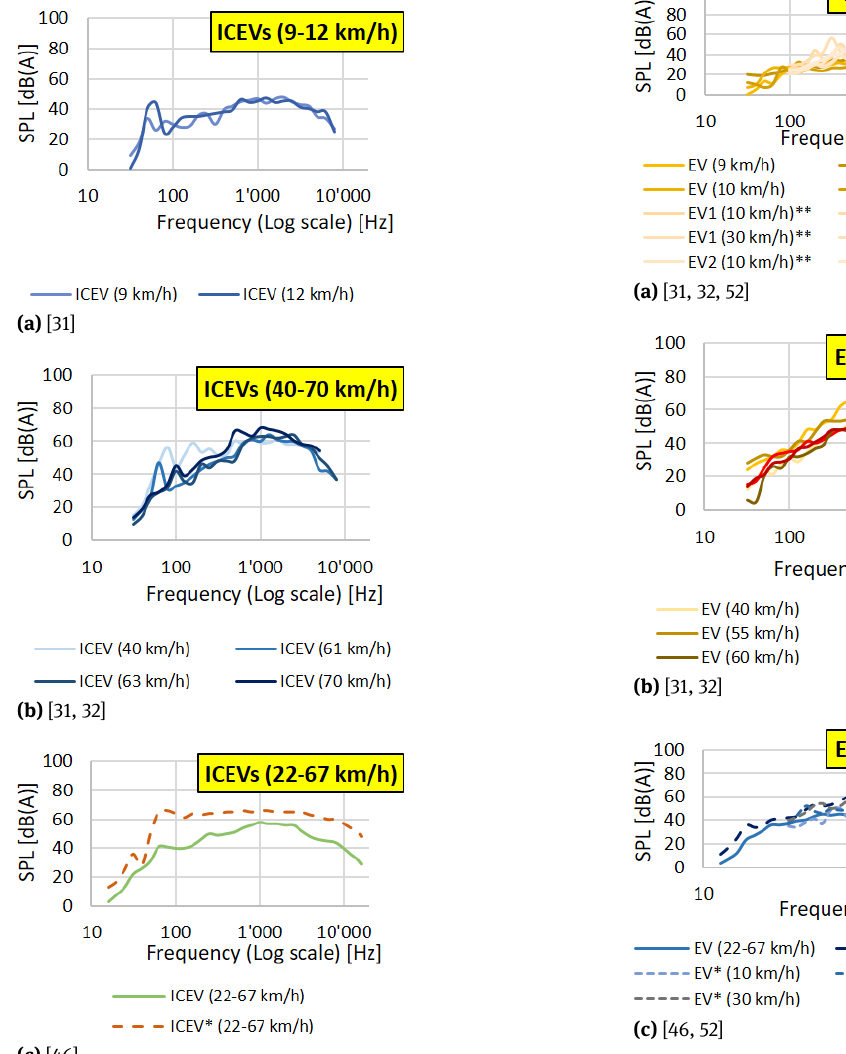
Figure 4: A-weighted Sound Pressure Level (Statistical Pass-By method, ISO 11819-1:1997) of EVs at different speeds (* = heavy vehicle; ** = motorcycle) [31, 32, 45,